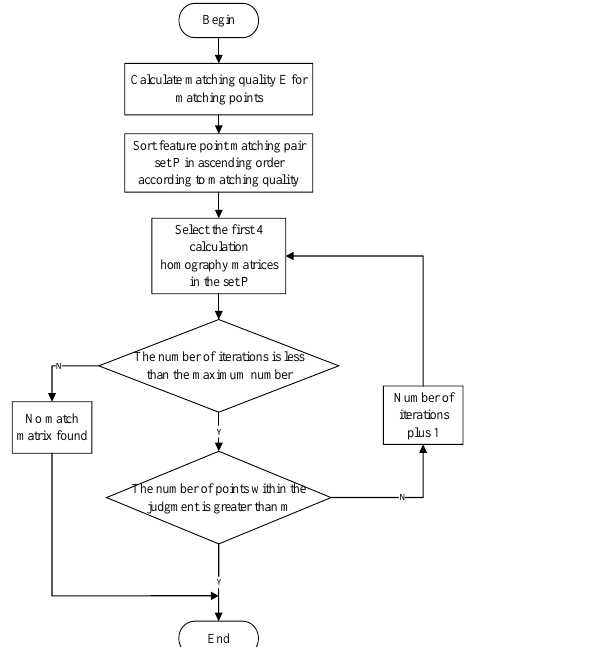
Fig. 4. Improved RANSAC algorithm flow char.